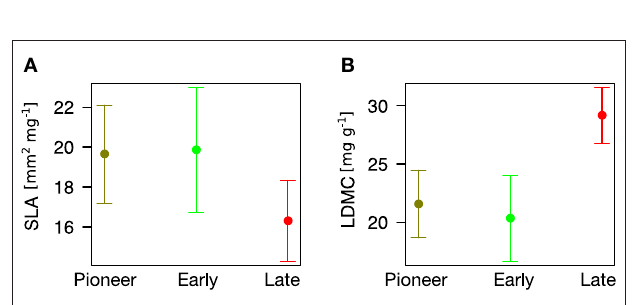
FIGURE 5 | Association between community type ( x -axis) and plant traits ( y -axis). (A) Specific Leaf Area. (B) Leaf Dry Matter